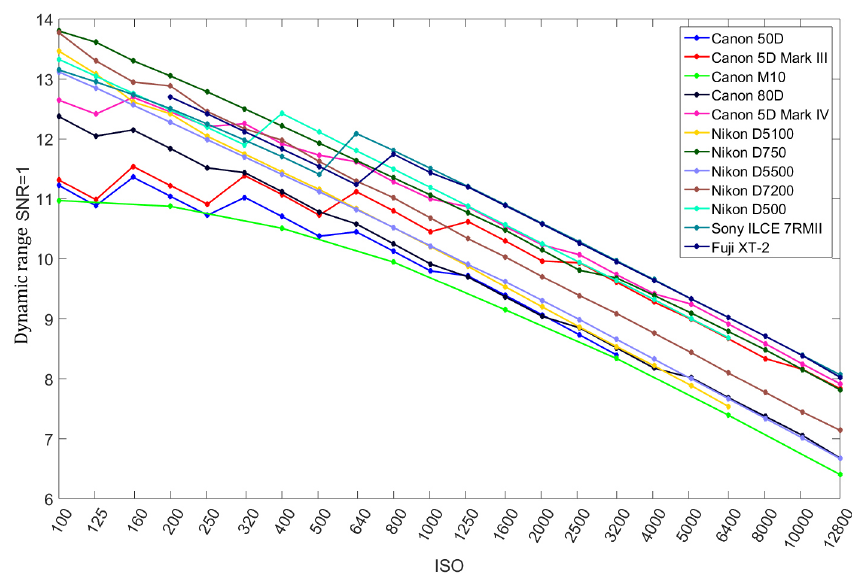
Figure 13. Pixel Dynamic Range for SNR = 0